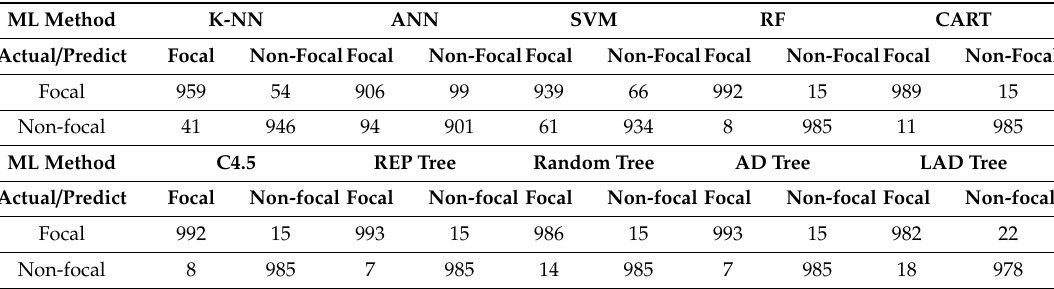
Table A5. Confusion matrix for Rotation Forest.